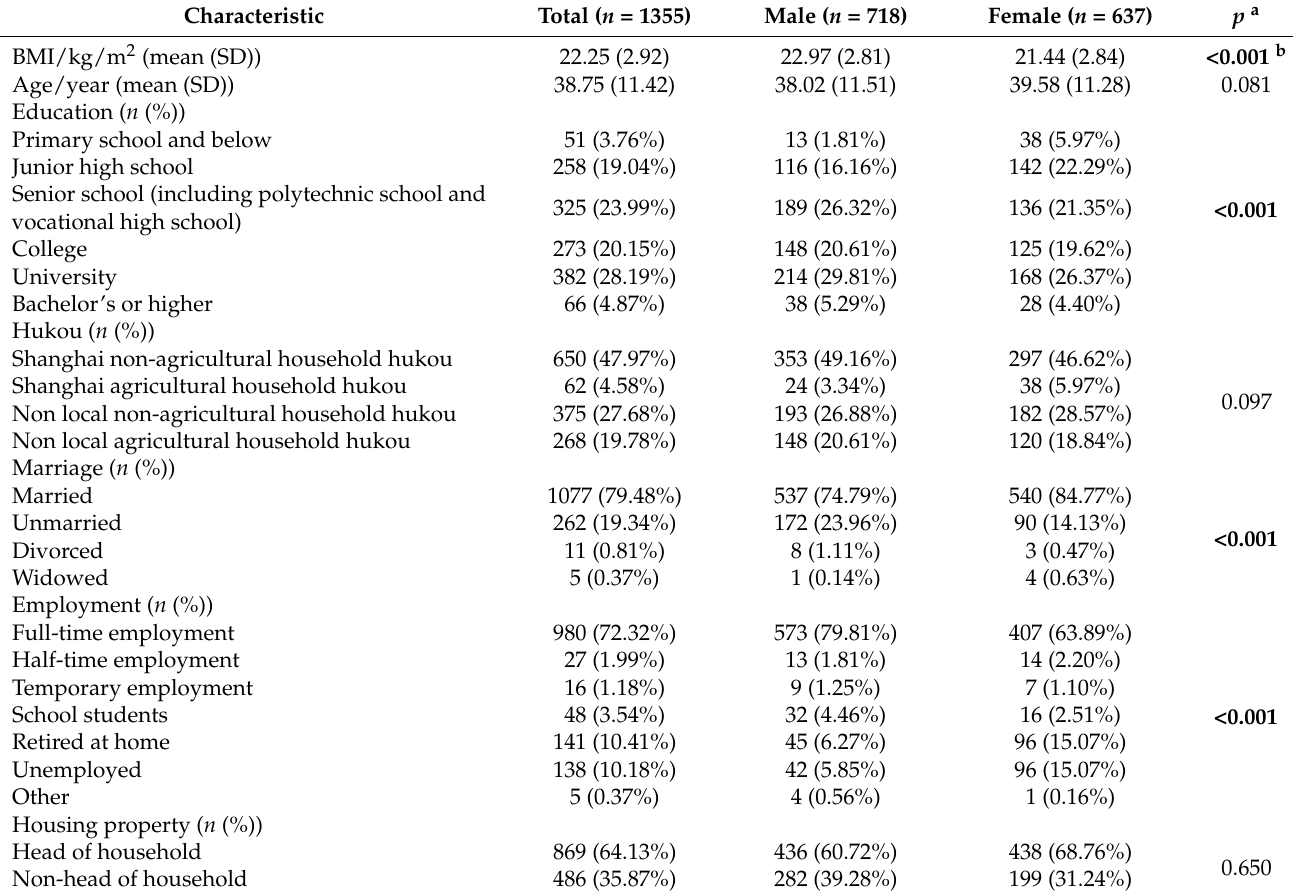
Table 1. Individual characteristics and differences between male and female participants ( n =